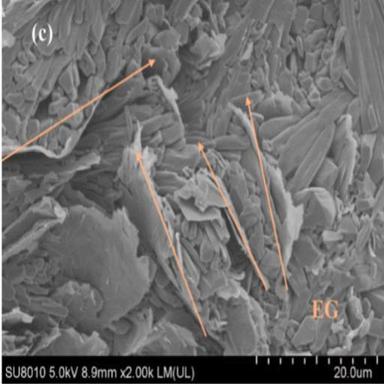
The SEM morphology of (a) CPCM1, (b) CPCM2, and (c) CPCM3.